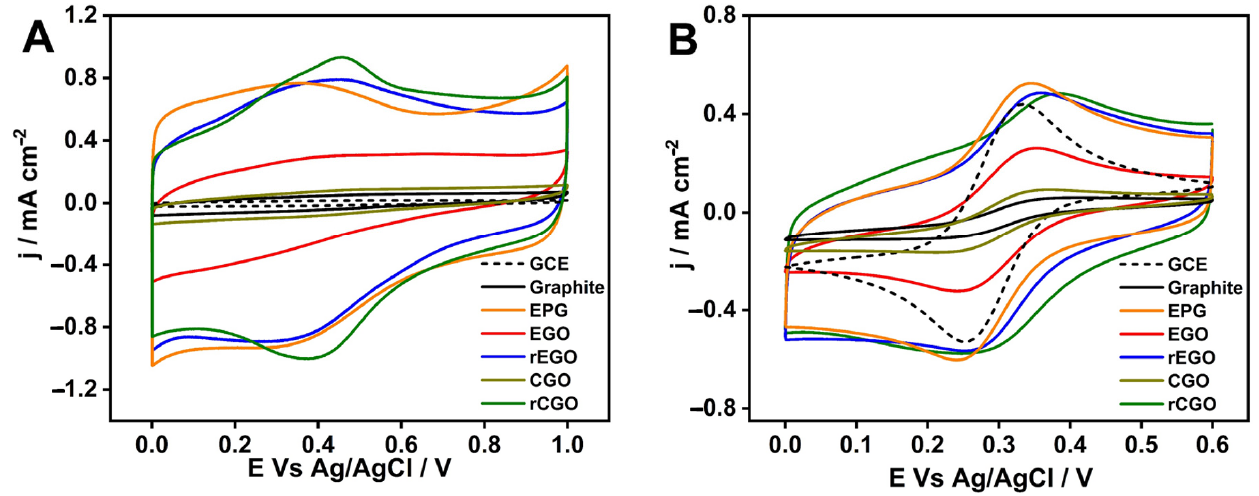
Figure 5. ( A ) Cyclic Voltammogram (CV) performed in 0.5 M H 2 SO 4 at a scan rate 100 mVs − 1 ; ( B ) CV performed at 50 mV s − 1 in 0.1 M KCl + 5 mM potassium ferricyanide.